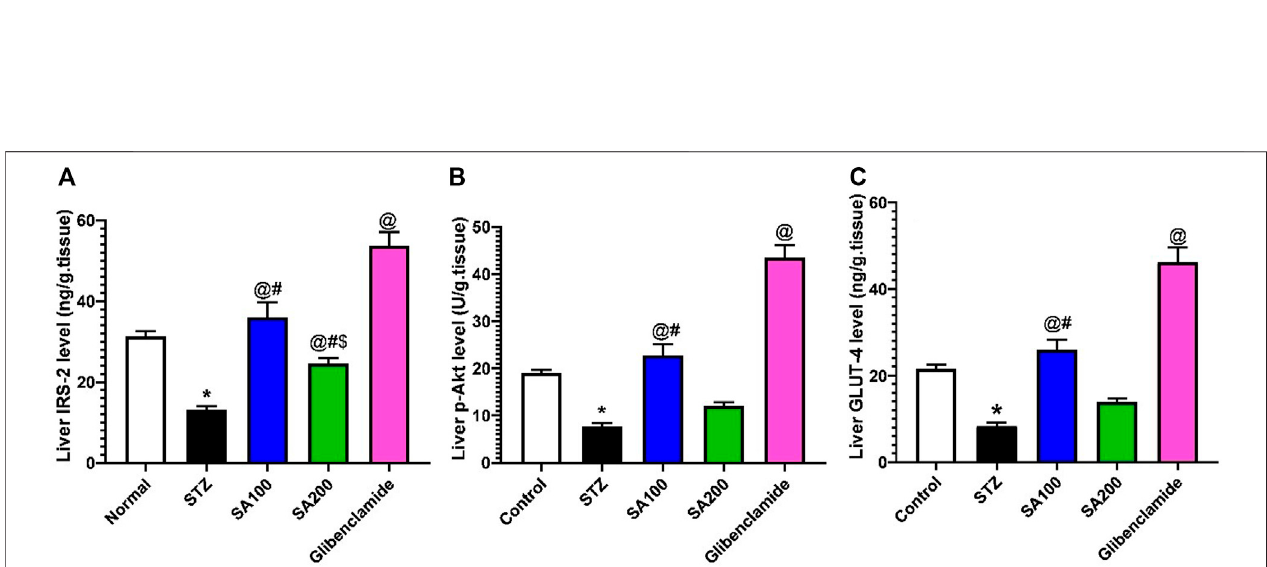
FIGURE9| Resultsfromtheoraladministrationoftheleafextractof S.aqueum (SA)onthelevelsofliver (A) insulinreceptorsubstrate-2(IRS-2), (B) phosphorylated protein kinase B (p-AKT), and (C) glucose transporter 4 (GLUT4) in STZ diabetic animals. Results are presented as mean ± SEM. *Signi fi cant difference related to the normal control group, @ related to STZ diabetic rats, # related to the reference drug group, glibenclamide, and $ related to SA 100 at p < 0.05 by One-Way ANOVA and Tukey ’ s post hoc test, n (cid:2) 6.